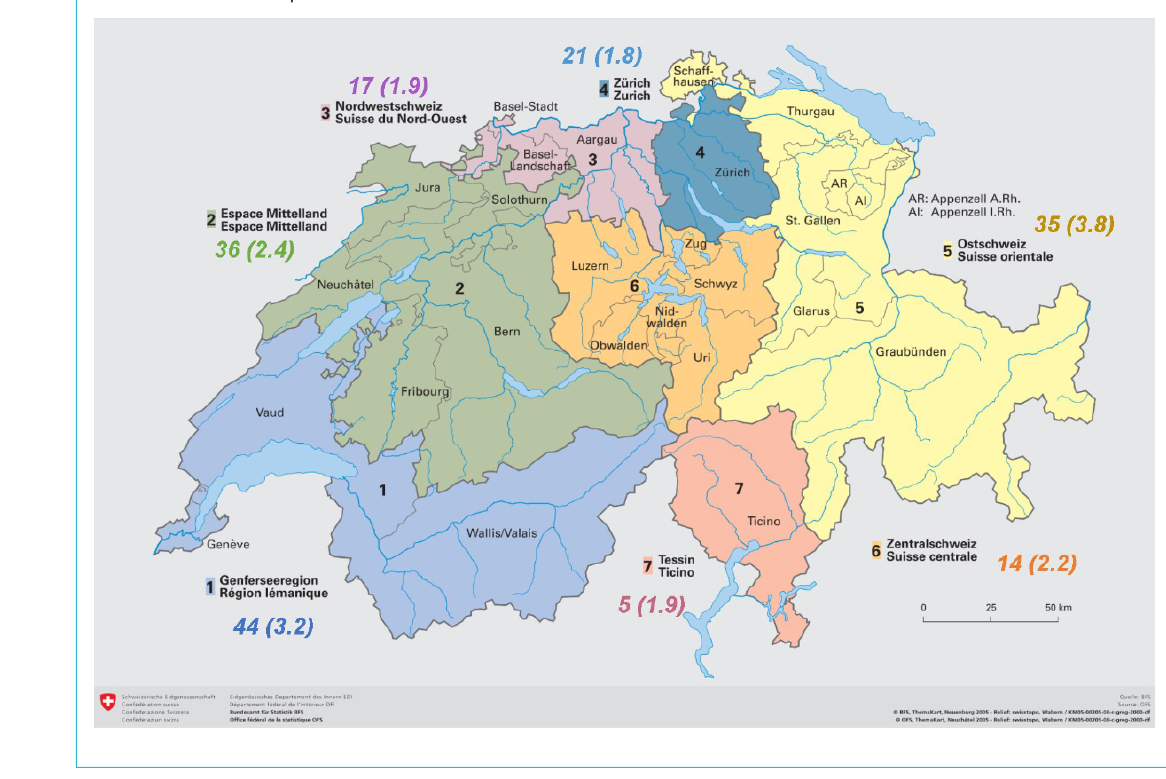
Figure 4: Geographical repartition of patients with Kawasaki disease in Switzerland, by residence. The major incidence was in “Suisse orien- tale” with 3.8/100,000 children under 18 years old per year and the lowest in Zurich with 1.8/100,000 children under 18 years old per year. (Comment: Three children were foreigners diagnosed during holidays. They don't appear on the map but are included in the study.). Copyright: Office fédéral de la